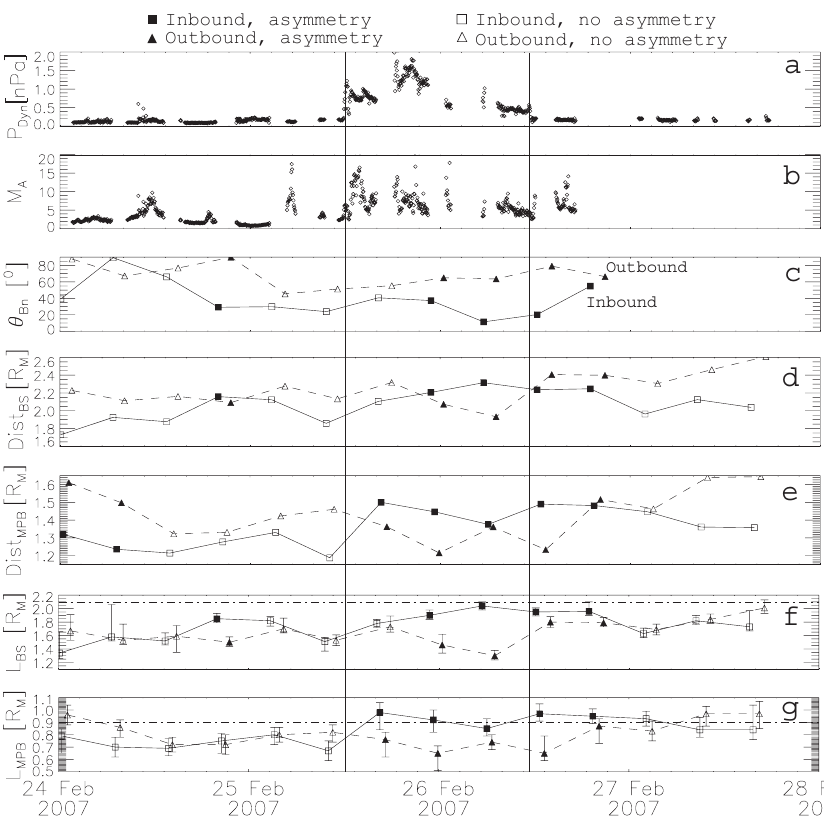
Fig. 3. Time series of (a) the MEX IMA dynamic pressure, (b) Rosetta MAG/MEX IMA Alfv´enic Mach number, (c) θ Bn , distance of each (d) BS and (e) MPB from the center of the planet as well as L-value of each (f) BS and (g) MPB together with error bars. Inbound θ Bn , distances and L-values are displayed as squares and connected by solid lines while the outbound ones are displayed as triangles and connected by dashed lines. Filled symbols indicate that there is an asymmetry present between the inbound and outbound boundaries. The values of L from Edberg et al. (2008) are indicated by dash-dotted lines in panels (f) and (g). The black vertical lines mark the interval of the high pressure solar wind.